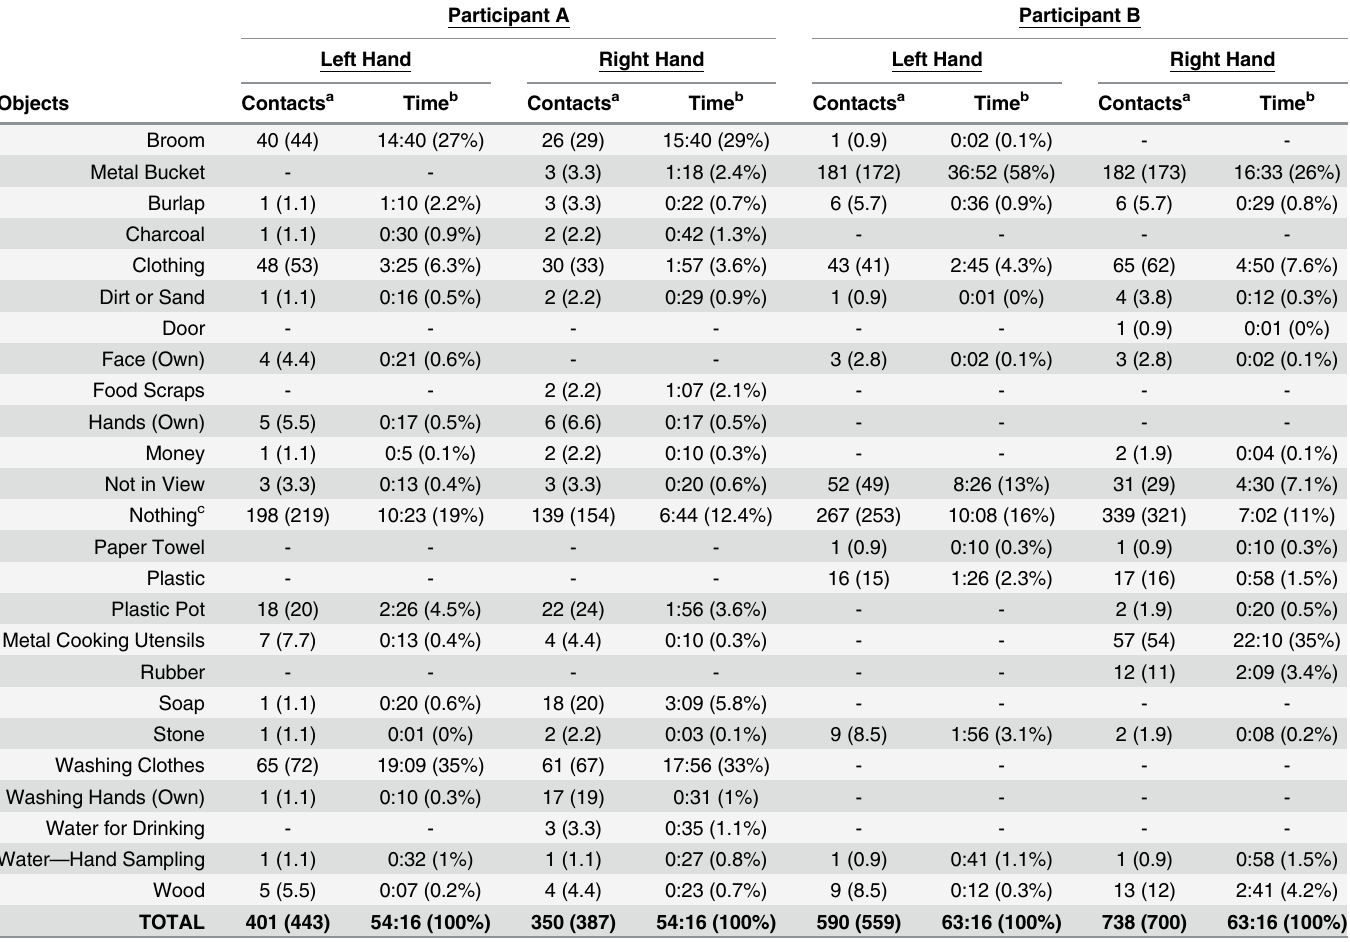
Table 4. Frequency and Duration of Hand Contacts with